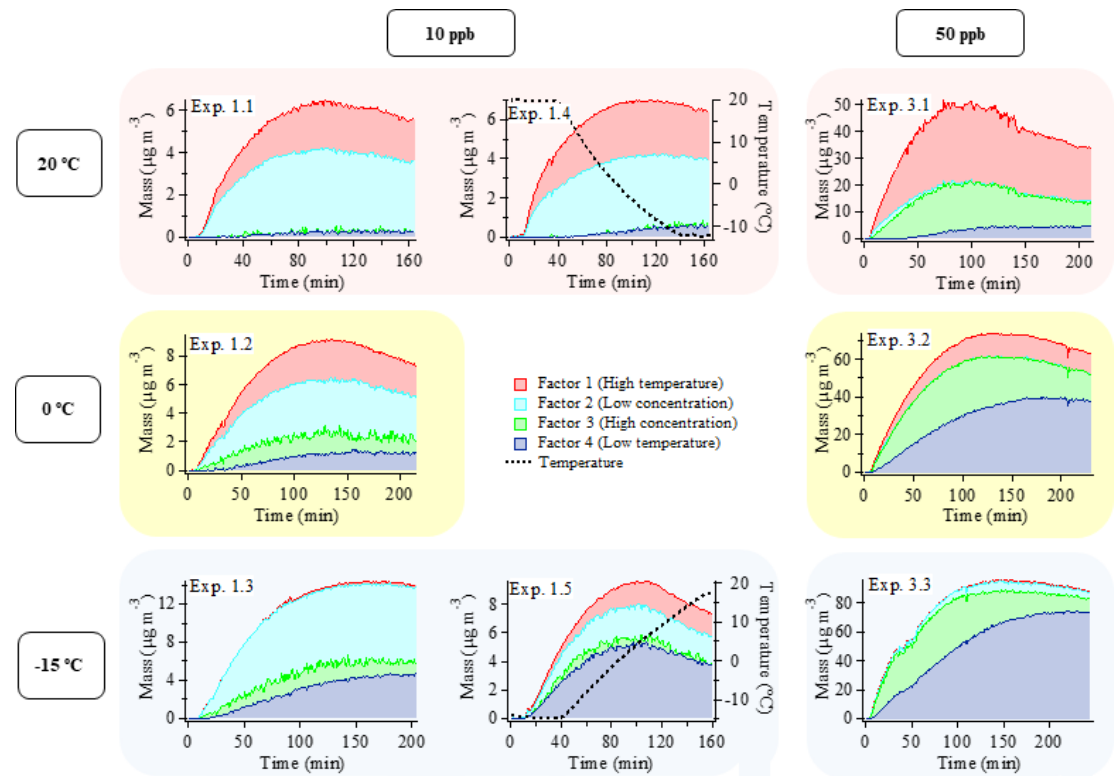
Figure 2. Mass evolution (µgm − 3 ) of the four factors from the PMF analysis of the combined AMS dataset including six constant temperature experiments with an initial α -pinene concentration of 10 or 50ppb, conducted at 20 ◦ C (experiments 1.1 and 3.1), 0 ◦ C (experiments 1.2 and 3.2), and − 15 ◦ C (experiments 1.3 and 3.3), and two temperature ramp experiments with an initial α -pinene concentration of 10ppb where the temperature was changed from 20 to − 15 ◦ C (experiment 1.4) and from − 15 to 20 ◦ C (experiment 1.5). Graphs in the left and middle columns depict 10ppb α -pinene experiments, and 50ppb α -pinene experiments are shown in the right column. Each row of graphs represents different initial temperatures. The reason for the bump/shoulder around 50min in experiment 3.3. is unclear.